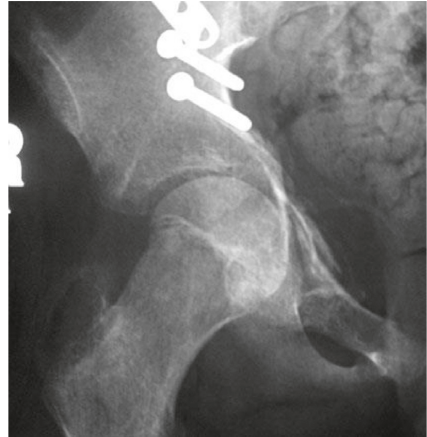
Figure 4: Medial displacement of both the quadrilateral surface and femoral head resulting in focal joint space narrowing at the superomedial joint surface.